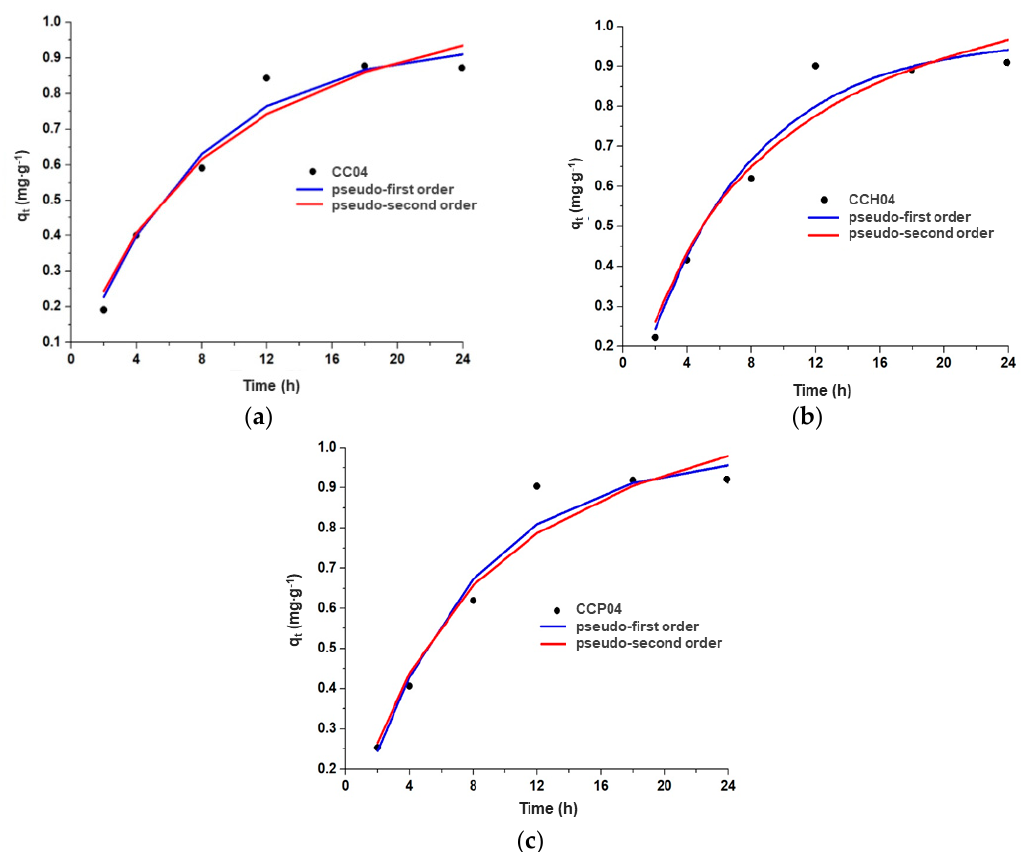
Figure 11. Kinetics models of the different synthesized materials: ( a ) CC04 copolymer, and ( b ) CCH04 and ( c ) CCP04 nanocomposites.